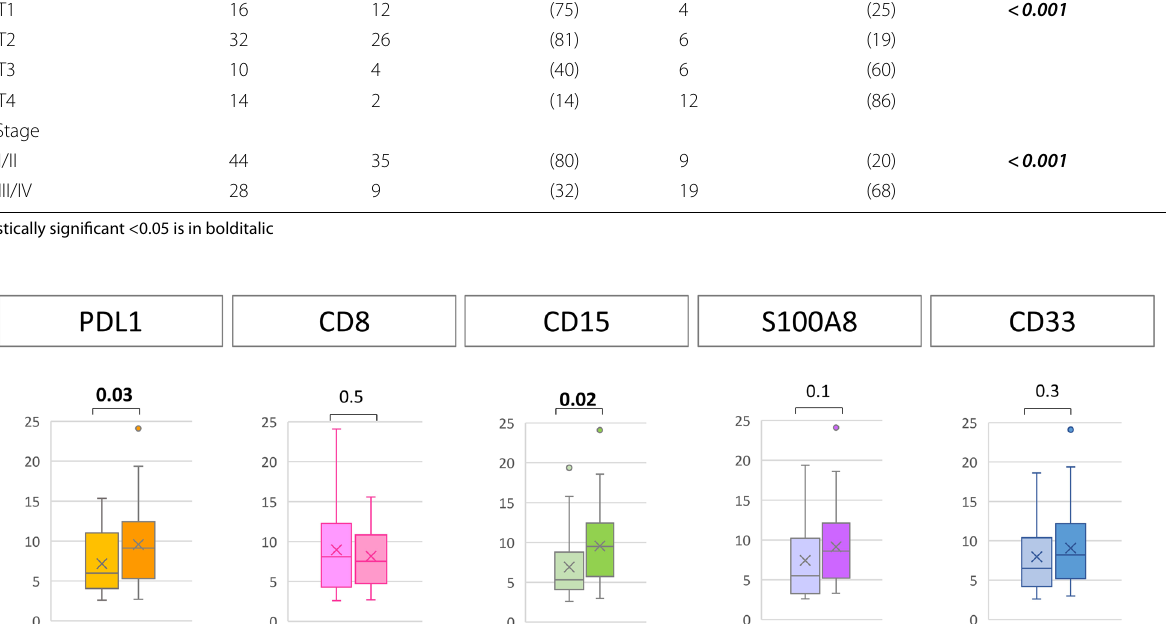
0.03 and P 0.02, = =